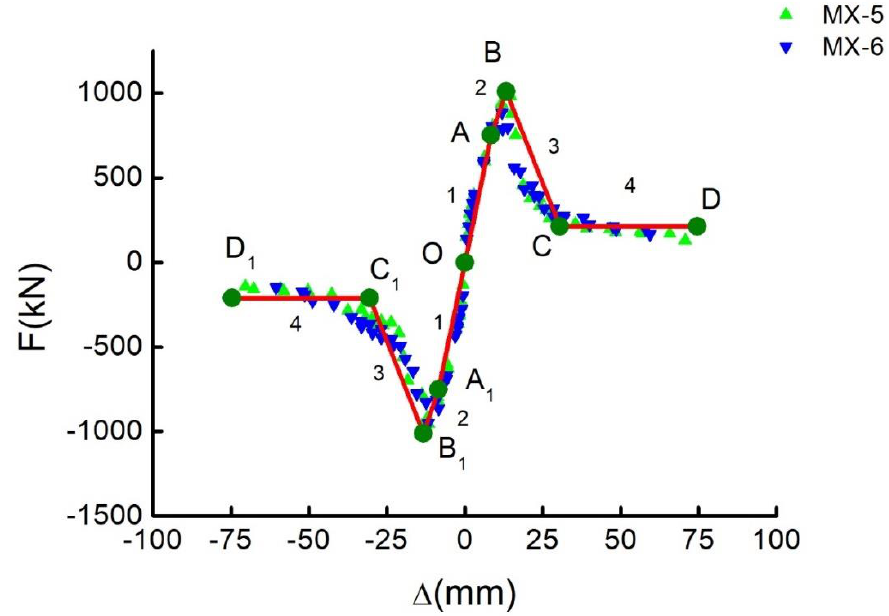
Figure 9. Comparison between skeleton curves obtained from fitting and actual experimental